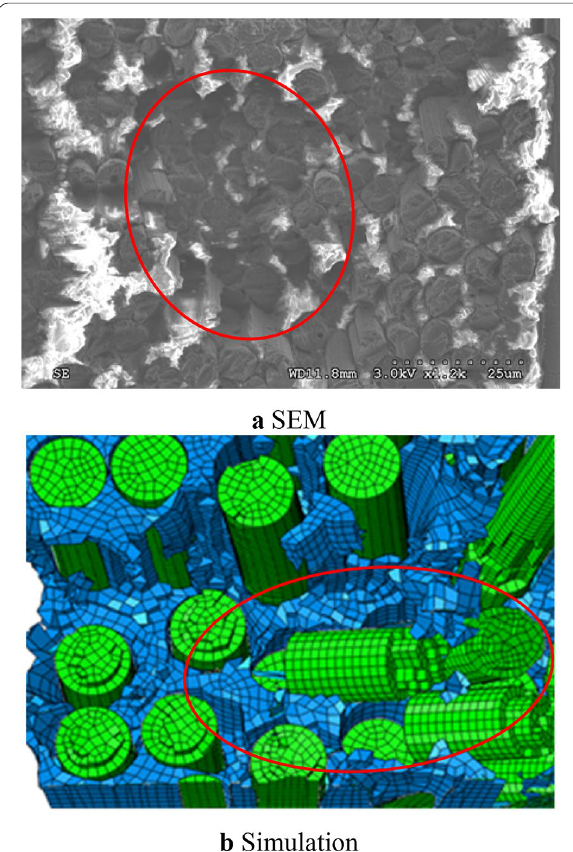
Figure 9 Thin elongated cracks induced by shedding carbon fibers